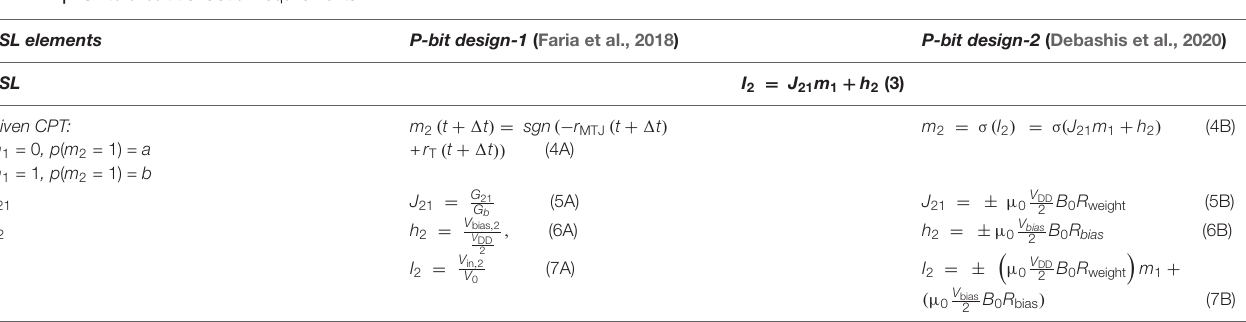
FIGURE 2 | Circuit implementation of a p-bit block. (A) PSL-based representation of two-node Bayesian network. (B) The p-bit design based on MTJ p-circuit with connection weight and bias to be connected to another node (Faria et al., 2018). (C) The p-bit design, based on nanomagnet p-circuit with connection weight and bias to be connected to another node (Debashis et al., 2020). (D) The required auxiliary node, X , for representing the four-node Bayesian network. TABLE 1 | PSL to circuit translation